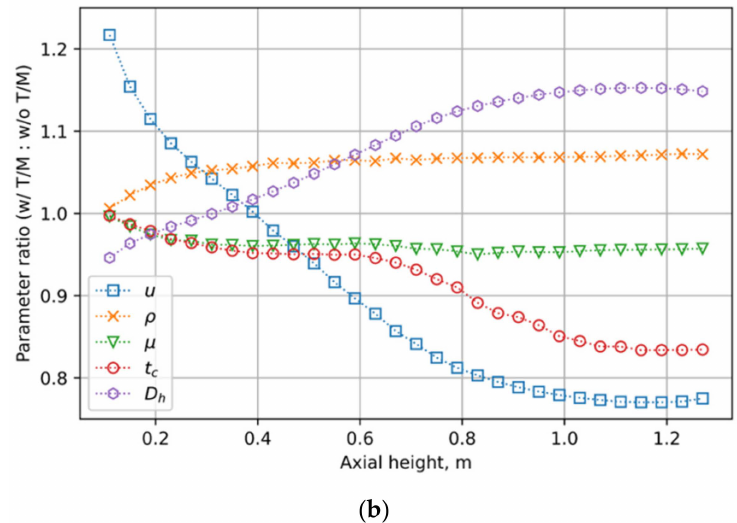
Figure 15. Comparison of the hot channel ( a ) heat transfer coefficient; ( b ) heat transfer component ratios as a function of axial